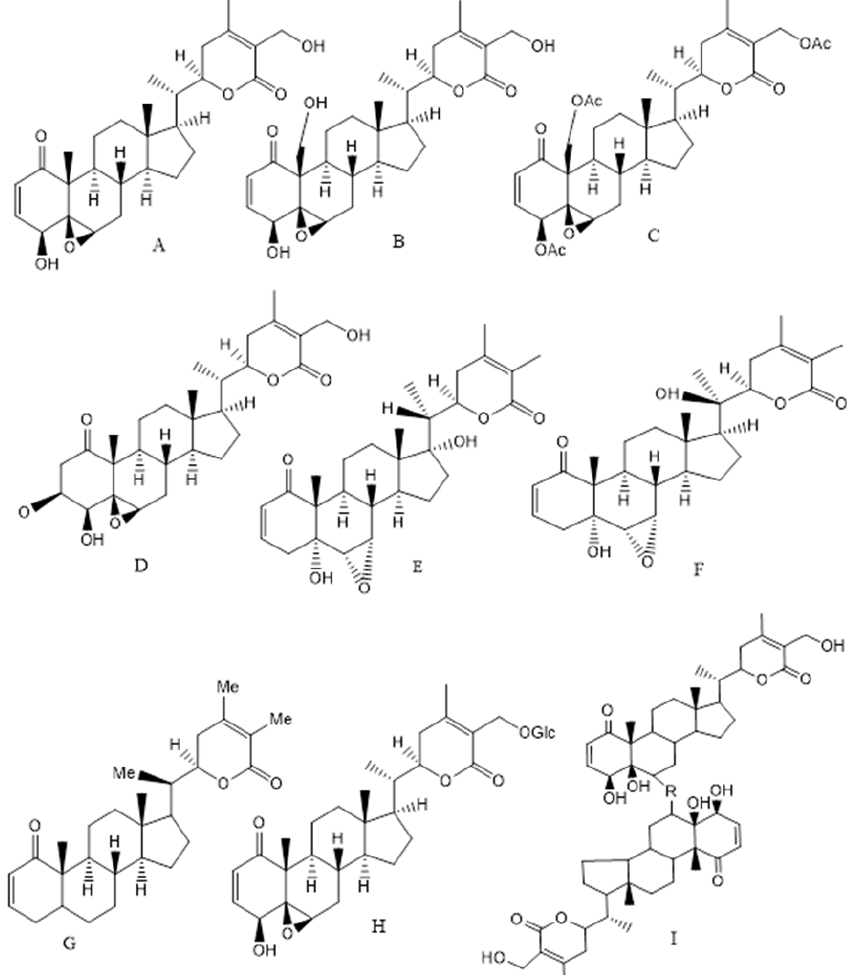
Figure 1. Structure of the Ashwagandha extract compounds from leaves, roots, stem and fruits ( A ) Withaferin A, ( B ) Withalongolide A, ( C ) Withaferin triacetate, ( D ) 2,3-Dihydro-3 β -methoxy Withaferin A, ( E ) Withanone, ( F ) Withanolide A, ( G ) Withanolide D, ( H ) Sitoindoside (IX) or 27-O-glucopyranosyl withaferin A and ( I ) Thiowithanolide (R = S and S =